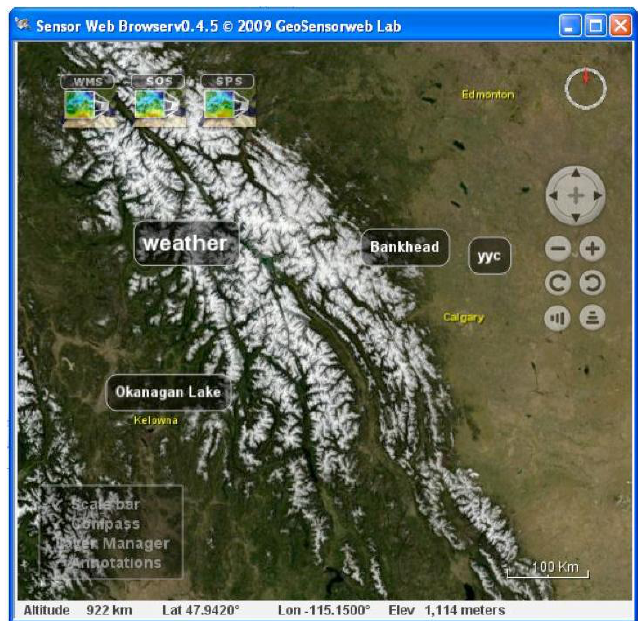
Figure 8. A screenshot of the GeoCENS recommendation engine tag